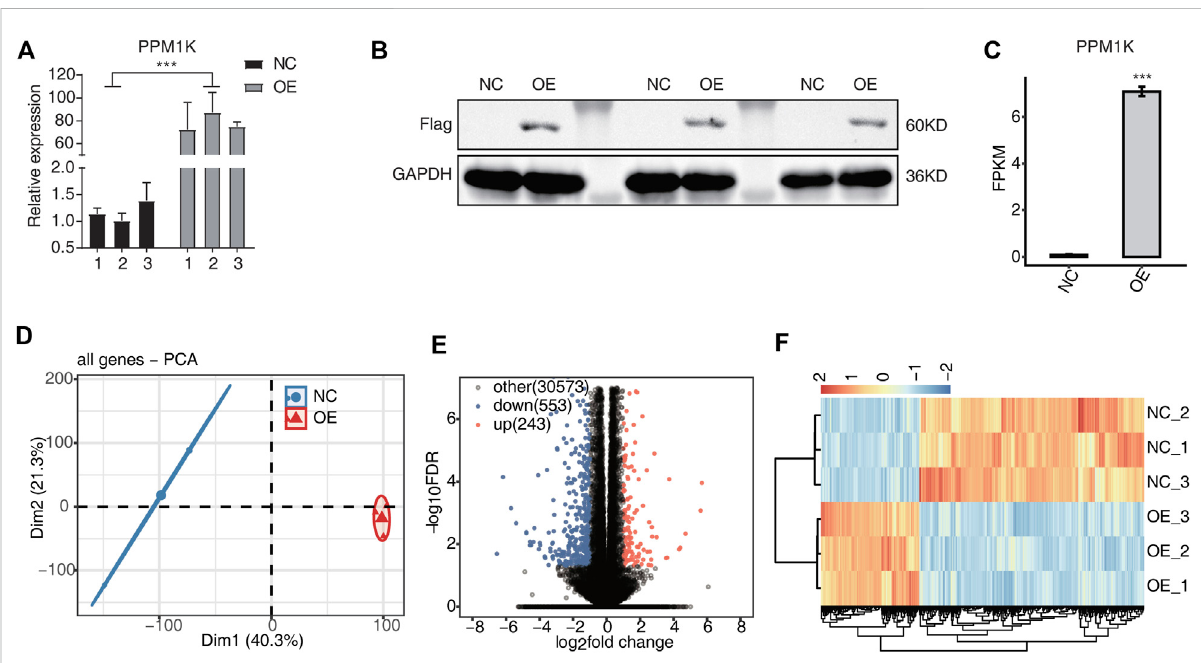
FIGURE 1 PPM1K -OE affect gene expressionpro fi les of HK2 cells (A) The histogram showed theRT-qPCR results of control and treatmentsamples. Error barsrepresentmean±SEM.*** p -value < 0.001. (B) Theresultofwesternblotexperimentshowedthatthe PPM1K overexpressionwassuccessful (C) Bar plot showing the expression pattern and statistical difference of DEGs for PPM1K . Error bars represent mean ± SEM. *** p -value < 0.001. (D) PCA base on FPKM value of all detected genes PPM1K overexpression. The ellipse for each group is the con fi dence ellipse (E) Volcano plot showing all differentially expressed genes (DEGs) between overexpression (OE) and Ctrl samples. (F) Hierarchical clustering heat map showing expression levels of all DEGs.